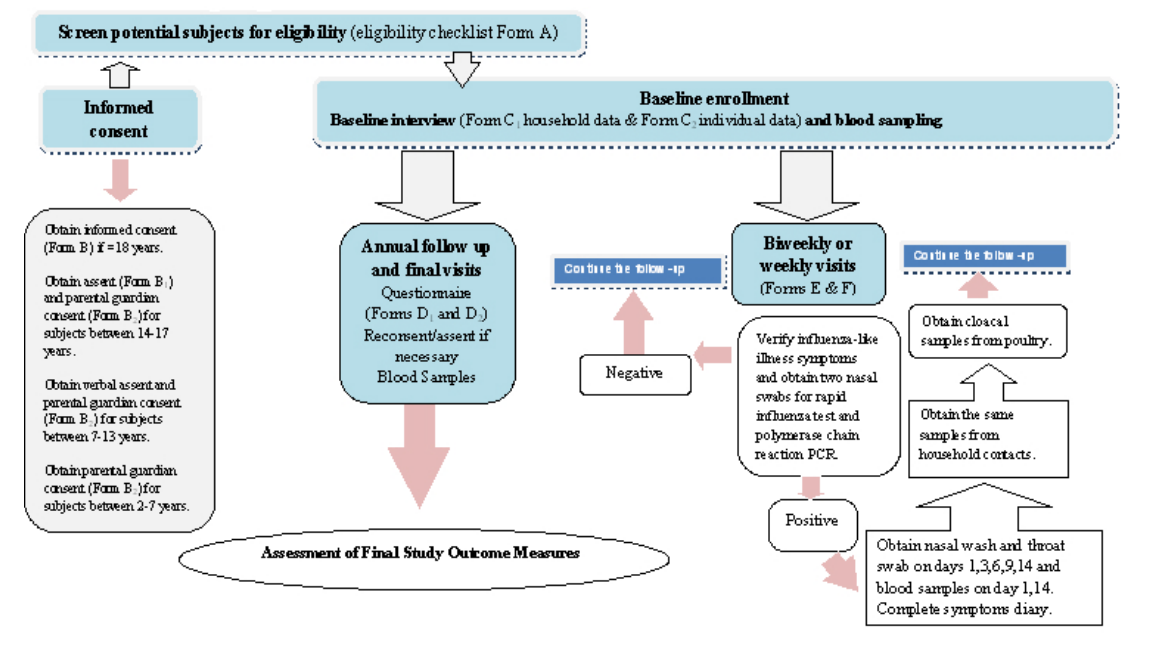
Figure 2. Schematic of the study